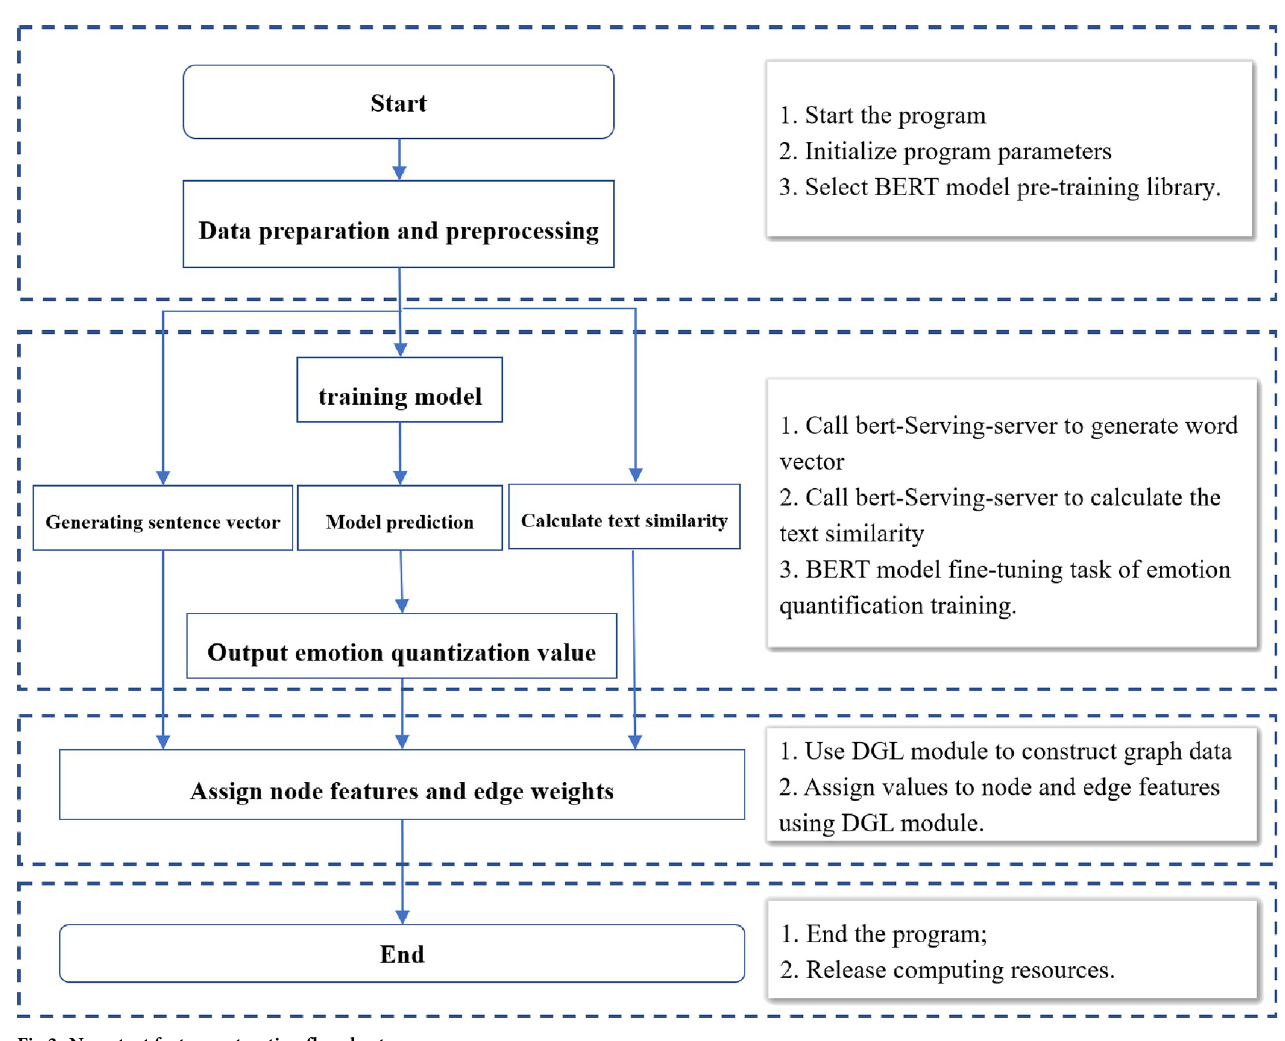
Fig 3. News text feature extraction